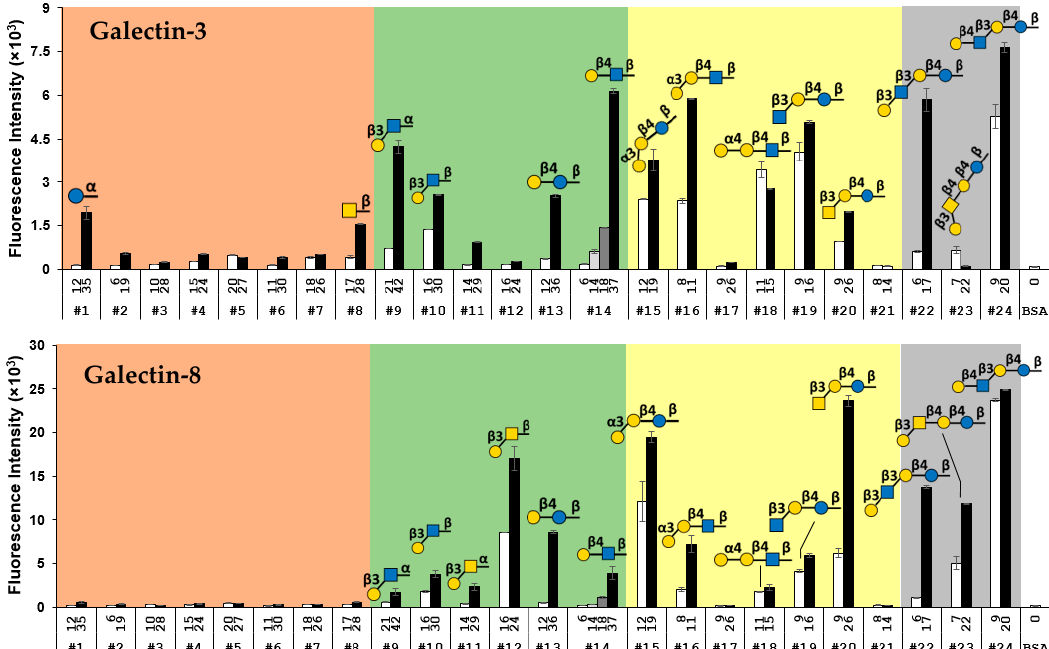
Figure 3. Binding profiles of galectin-3 and galectin-8. The names of glycans are shown in Table S1. The value above each glycan number represents the glycan valency of each glycan-BSA conjugate. The data are presented as the mean ± standard deviation of duplicates.